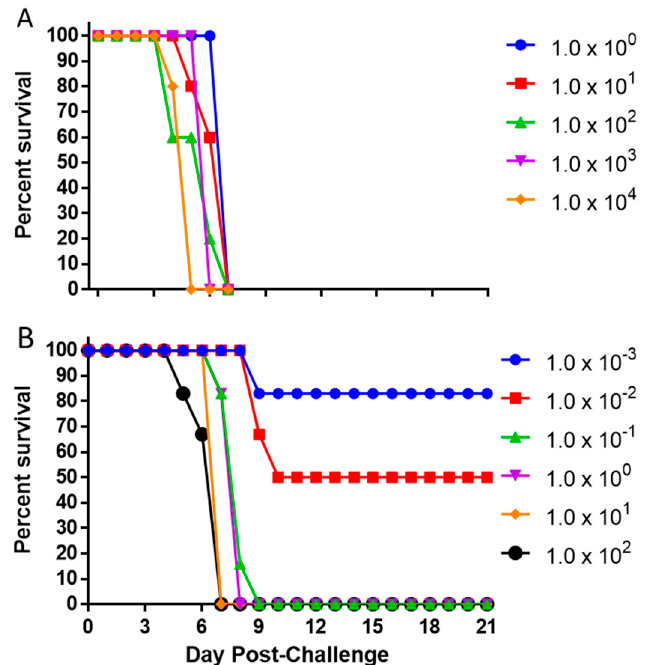
Figure 2. Survival after Challenge with Various Doses of EBOV. Mice (N = 5) were challenged with 1.0 × 10 4 –1.0 × 10 0 pfu of EBOV ( A ). In a separate experiment, mice (N = 6) were challenged with 1.0 ×